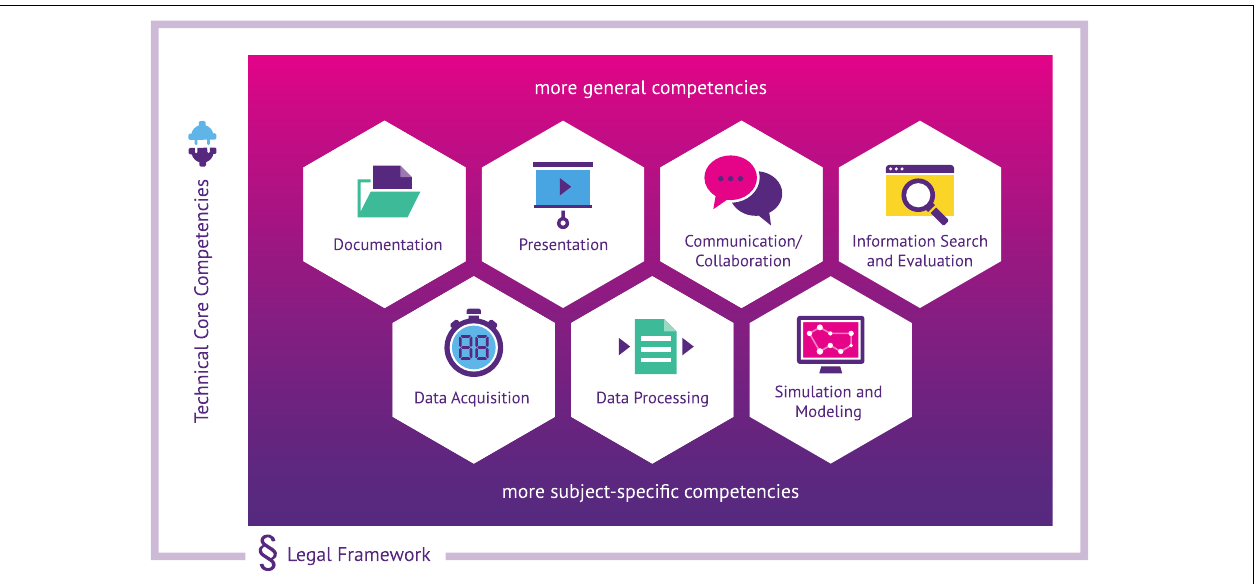
FIGURE 1 | The DiKoLAN-TG framework image is identical to the DiKoLAN framework image